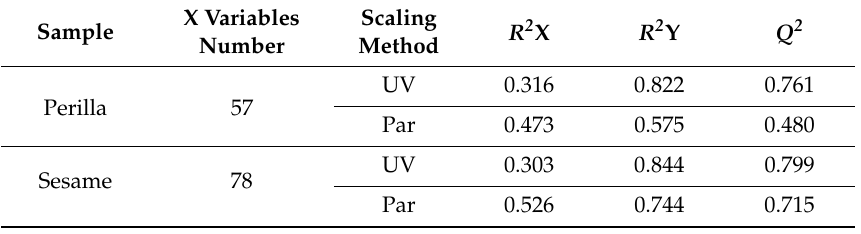
UV—unit variance;